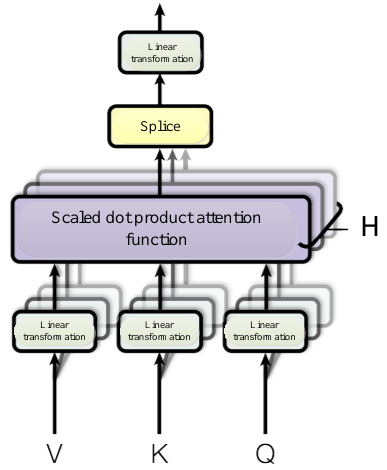
Figure 5. Multi-head Self-Attention mechanism.